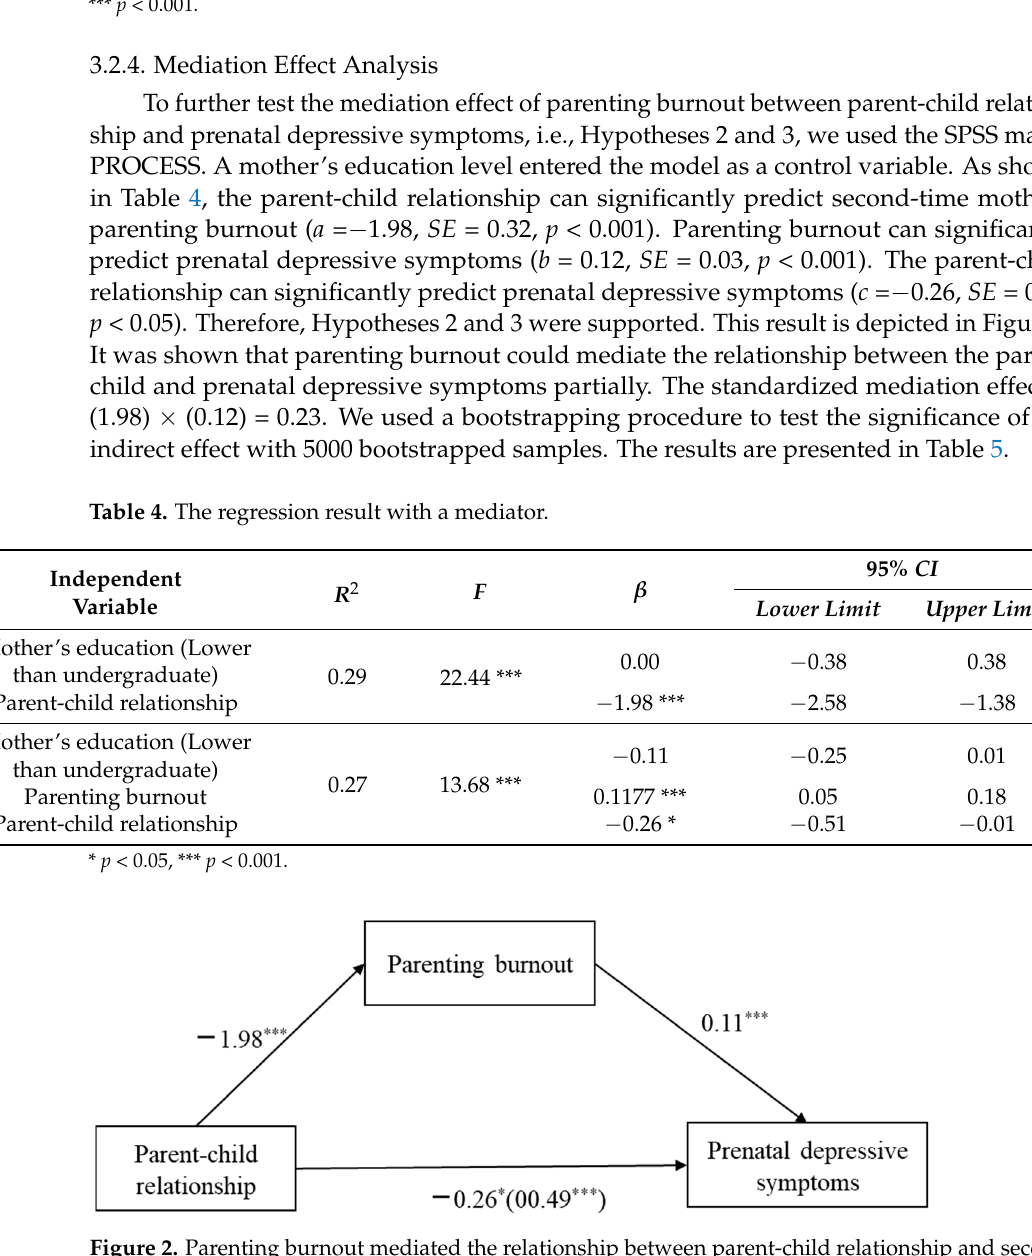
Figure 2. Parenting burnout mediated the relationship between parent-child relationship and sec- ond-time mothers’ prenatal depressive symptoms with standardized coefficients. * p < 0.05, *** p <